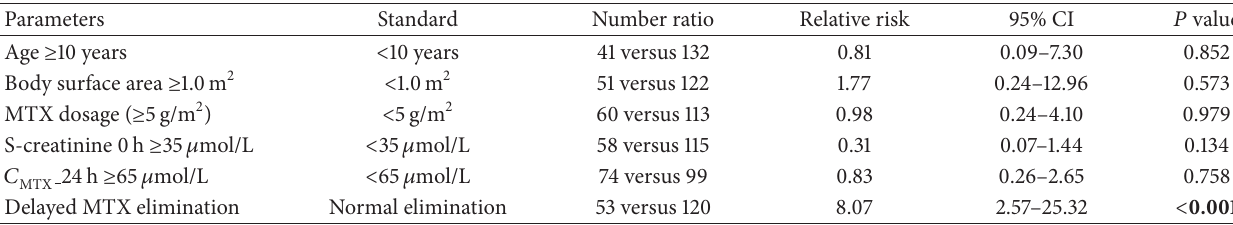
Table 2: Possible parameters related to CCR decrease > 50%.